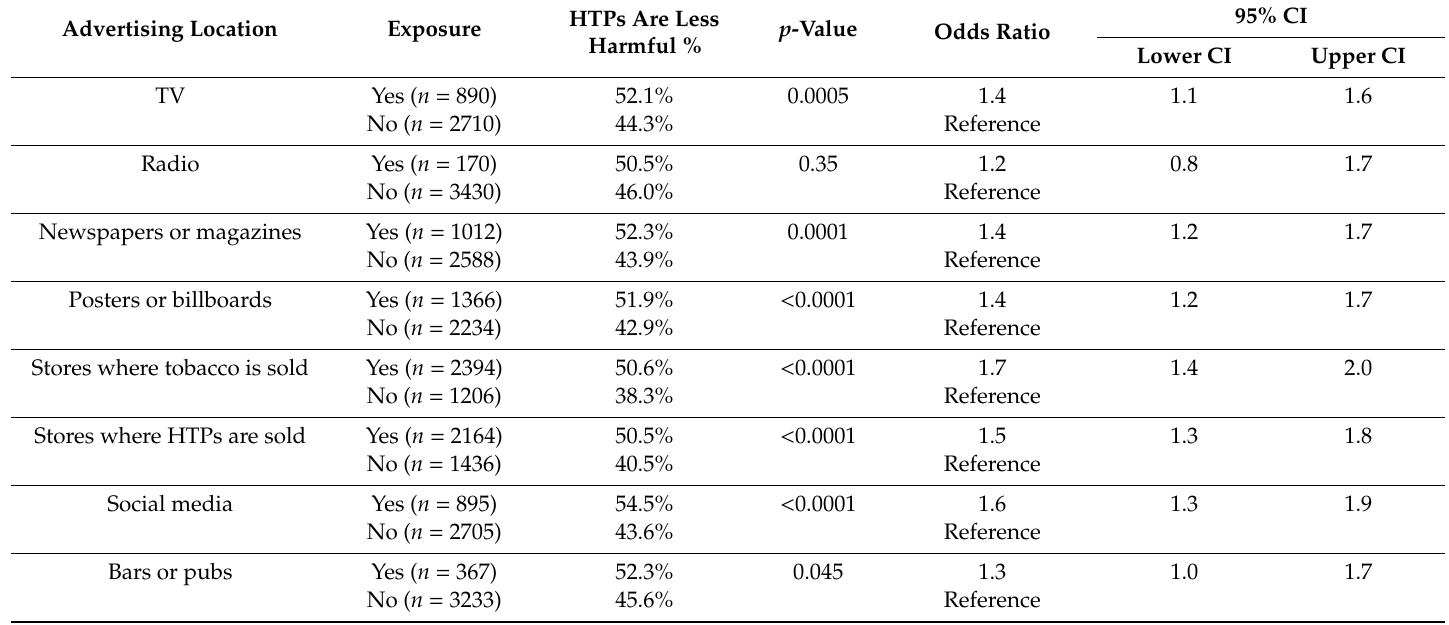
Table 3. Adjusted (weighted) regression models estimating the odds of believing that HTPs are less harmful than cigarettes among smokers in Japan in 2018 based on exposure to various marketing platforms ( n =